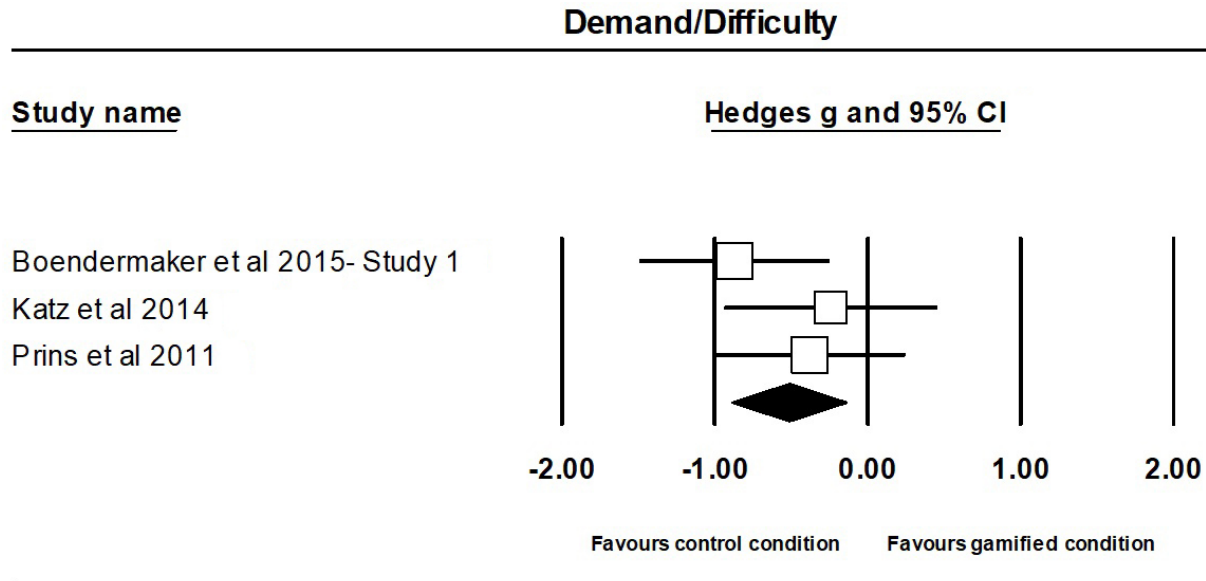
Figure 4. Forest plot of overall effect sizes comparing gamified condition and control condition (ie, non- or less-gamified version) on demand/difficulty for individual studies in alphabetical